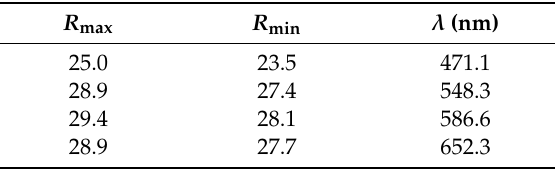
Table 2. Reflectance data for richardsite.